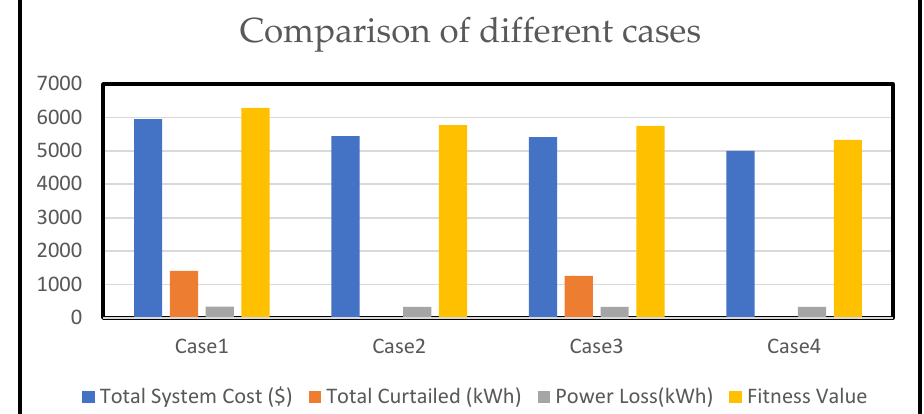
Figure 28. The impact of all four cases on the cost and losses.